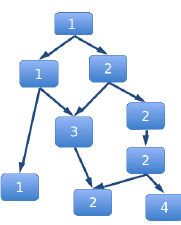
Figure 4. Each node is labeled by its replica identifier